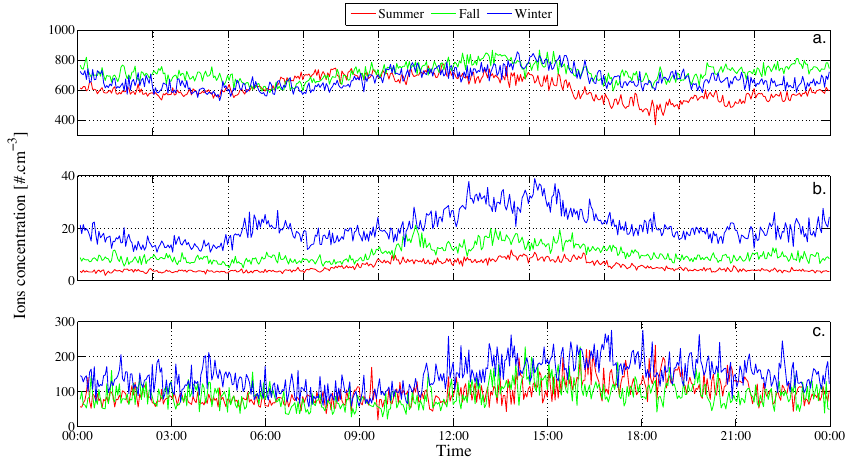
Fig. 1. Median diurnal variation of positive ion size class concentrations from July 2008 to April 2009. (a) Cluster ions, (b) Intermediate ions and (c) Large ions. Summer: July–September 2008, Fall: October–December 2008, Winter: January–March